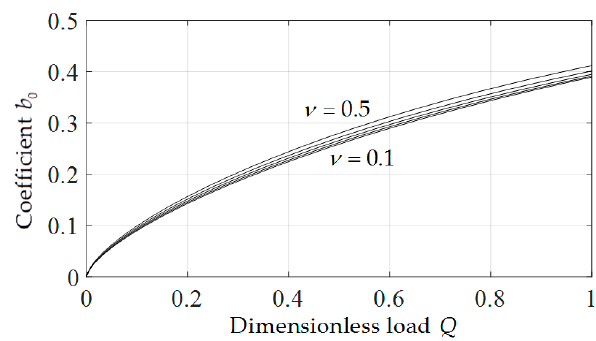
Figure 10. Variation of b 0 with Q .